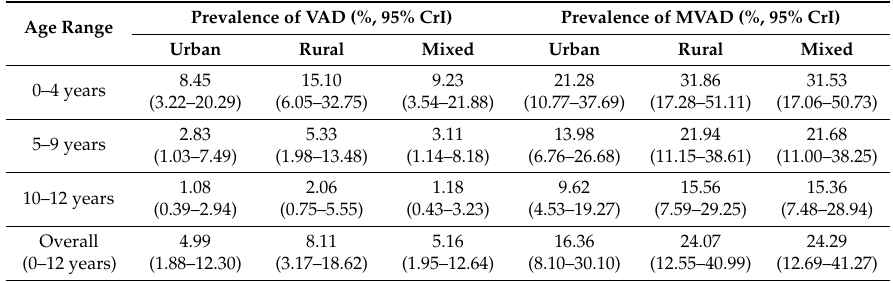
Table 1. Estimated setting ‐ specific prevalence of VAD and MVAD in Chinese children in 2015, by age group.